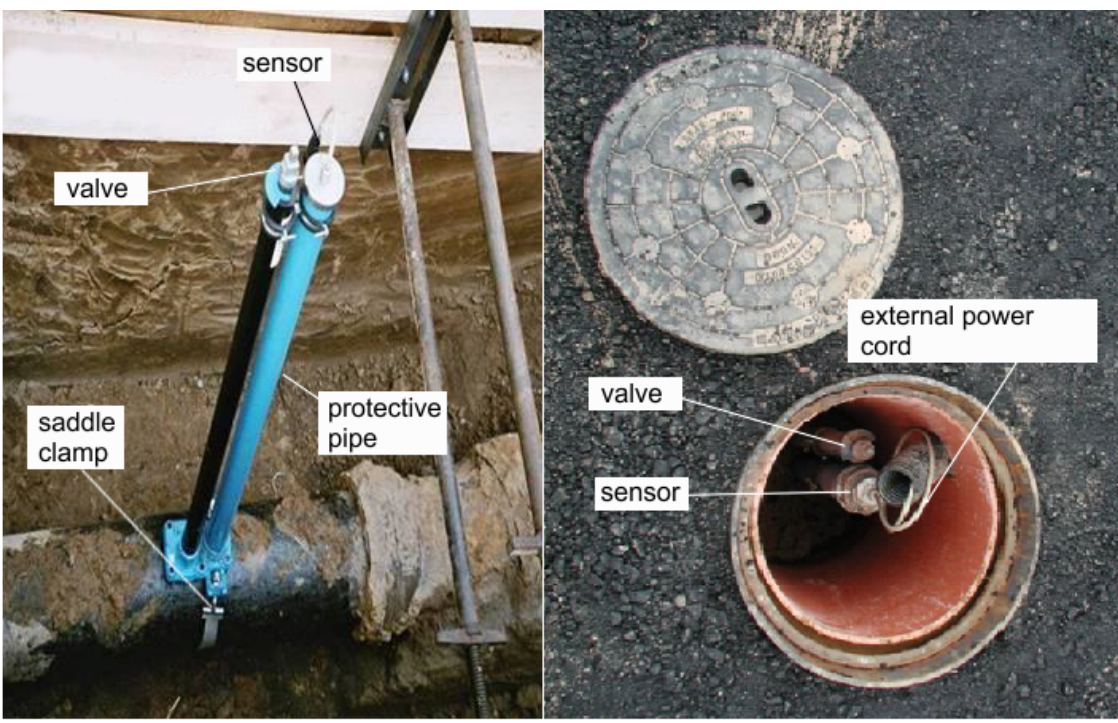
Figure 6: Installation of the WLM